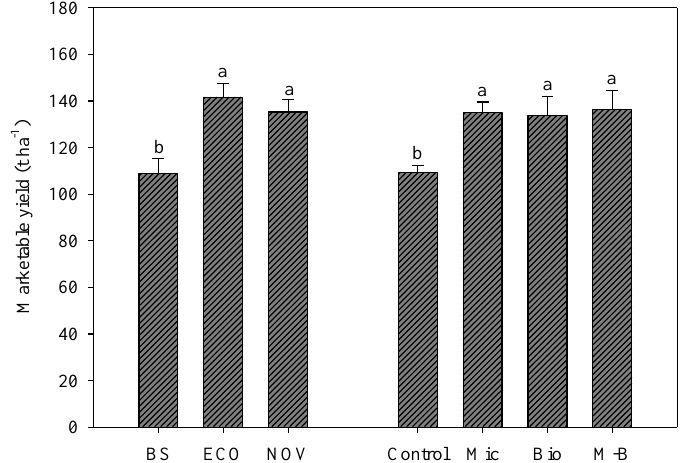
Figure 2. Tomato marketable yield as affected by mulching (ECO: biodegradable film Ecovio; NOV: biodegradable film MaterBi ® ; BS: bare soil) and biostimulant application (Bio: treated with Phylgreen ® ; Mic: treated with Trianum-P ® ; M-B: combination of Bio and Mic; Control: not treated). Each column indicates the mean value of the three replicates. Vertical bars indicate standard error; different letters indicate significant differences according to Tukey’s test ( p < 0.05). Table 2. Number per square meter and average weight of marketable tomato fruits, and production, number per square meter, and average weight of green, and rotten tomato fruits as affected by mulching (ECO: biodegradable film Ecovio; NOV: biodegradable film MaterBi ® ; BS: bare soil) and biostimulant application (Bio: treated with Phylgreen ® ; Mic: treated with Trianum-P ® ; M-B: combination of Bio and Mic; Control: not